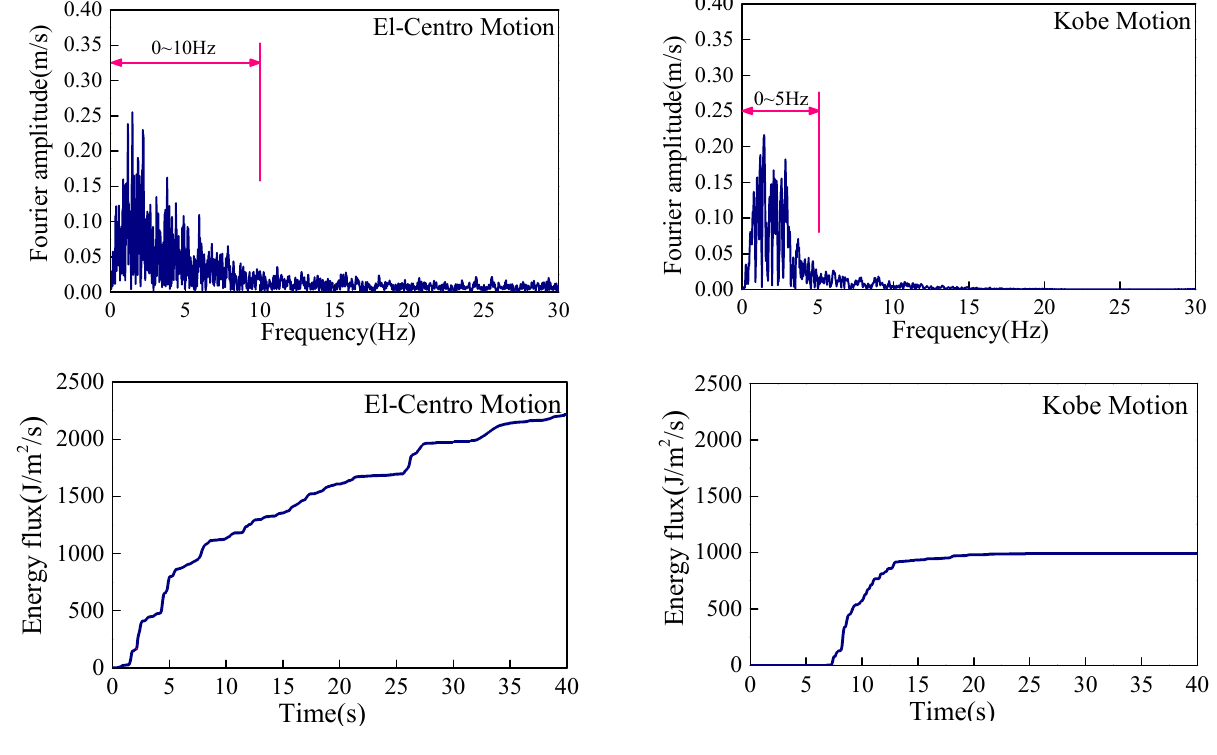
Figure 3. Acceleration time histories, Arias intensity build-up, and Fourier spectra of the input motions. Table 3. Parameters of the two ground-motion records used in this study.